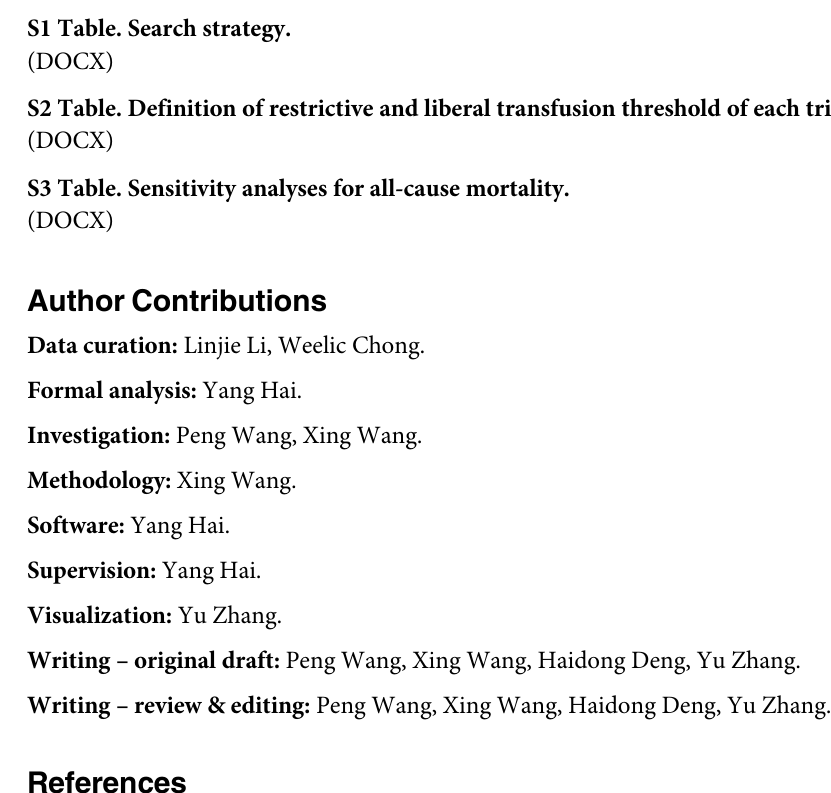
S10 Fig. Forest plot comparing RR of sepsis between restrictive and liberal RBC transfu- sion for VLBW infants. S11 Fig. Forest plot comparing MD of length of hospital stay between restrictive and lib- eral RBC transfusion for VLBW infants. S12 Fig. Forest plot comparing RR of intraventricular hemorrhage grade 3 and above between restrictive and liberal RBC transfusion for VLBW infants. S13 Fig. Forest plot comparing MD of hemoglobin levels between restrictive and liberal RBC transfusion for VLBW infants. S1 Table. Search strategy. S2 Table. Definition of restrictive and liberal transfusion threshold of each trial. S3 Table. Sensitivity analyses for all-cause